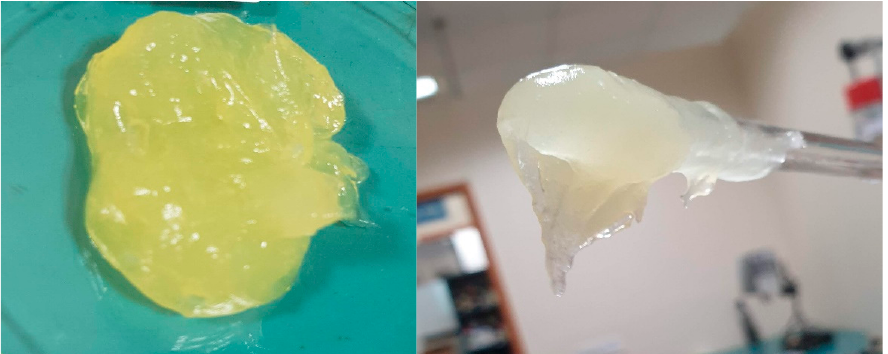
Figure 1. Silymarin mucoadhesive gel . Table 1. Various parameters evaluated in the chosen silymarin gel formulation (F10)